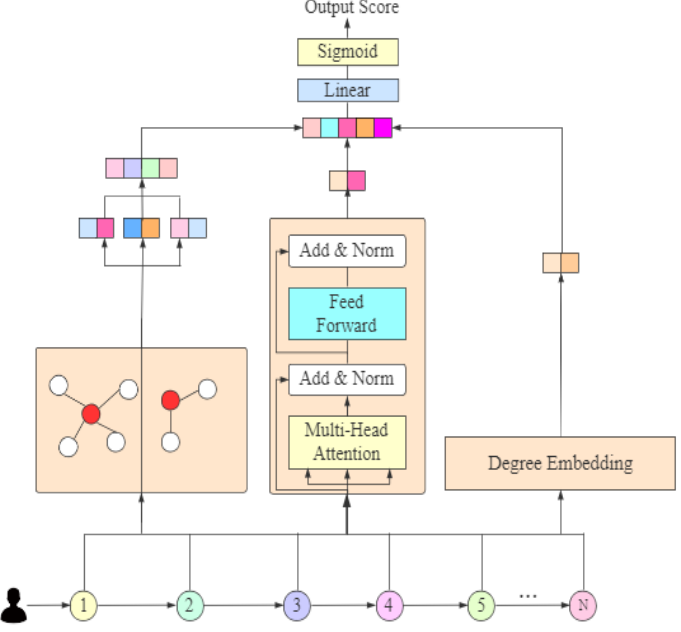
Figure 1. The structure of our